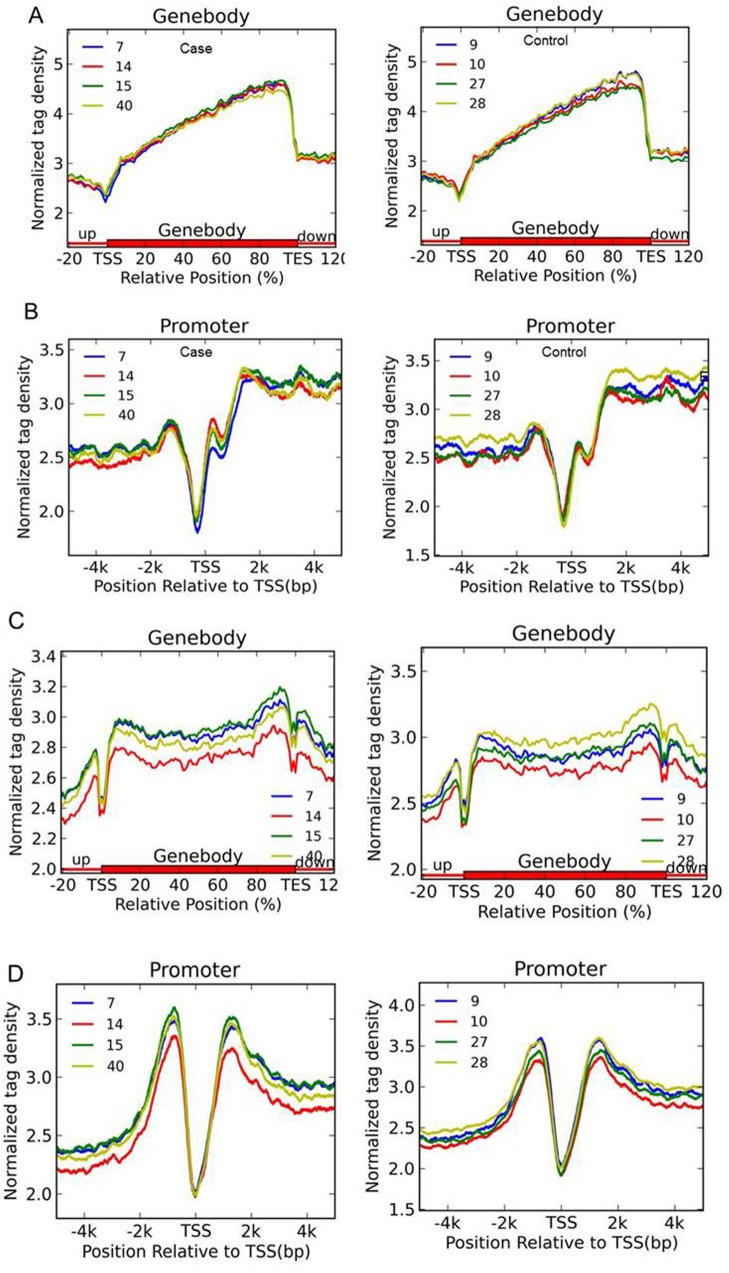
Genome-wide mapping of 5mC and 5hmC in placentas of late-onset severe PE and normal pregnant women.(A and C) Normalized DMR (A) and DHMR(C) tag density distribution across the gene body. Each gene body was normalized to 0%-100%. Normalized Tag density is plotted from 20% of upstream of TSSs to 20% downstream of TSSs(Transcription Start Sites). (B and D) Normalized DMR (B) and DHMR (D) tag density distribution at gene promoters. -5 kb to +5 kb relative to TSSs is shown.